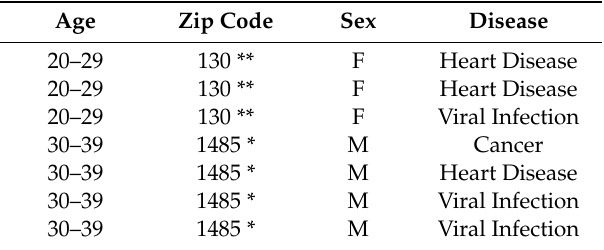
Table 3. Microdata in p-sensitive privacy